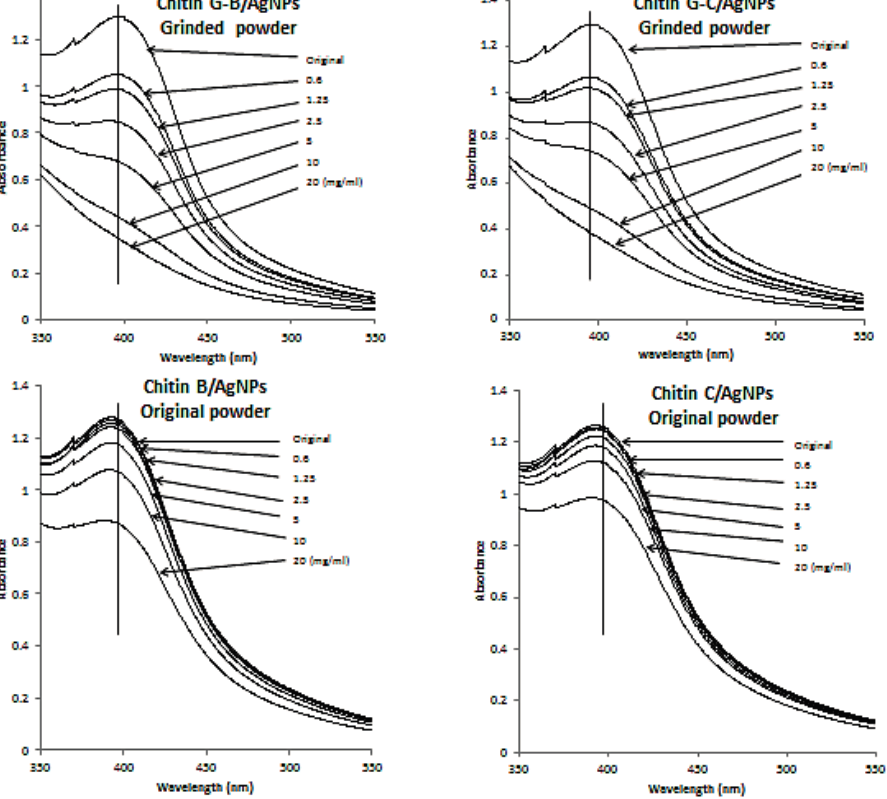
Figure 3. UV-Vis spectra of original Ag NPs in suspension (original) and supernatants of postreaction mixtures in which various amounts of chitins G-B, B, G-C, or C were reacted with Ag NPs. Excess Ag NPs in the supernatants of postreaction mixtures decreased as the amount of chitin added